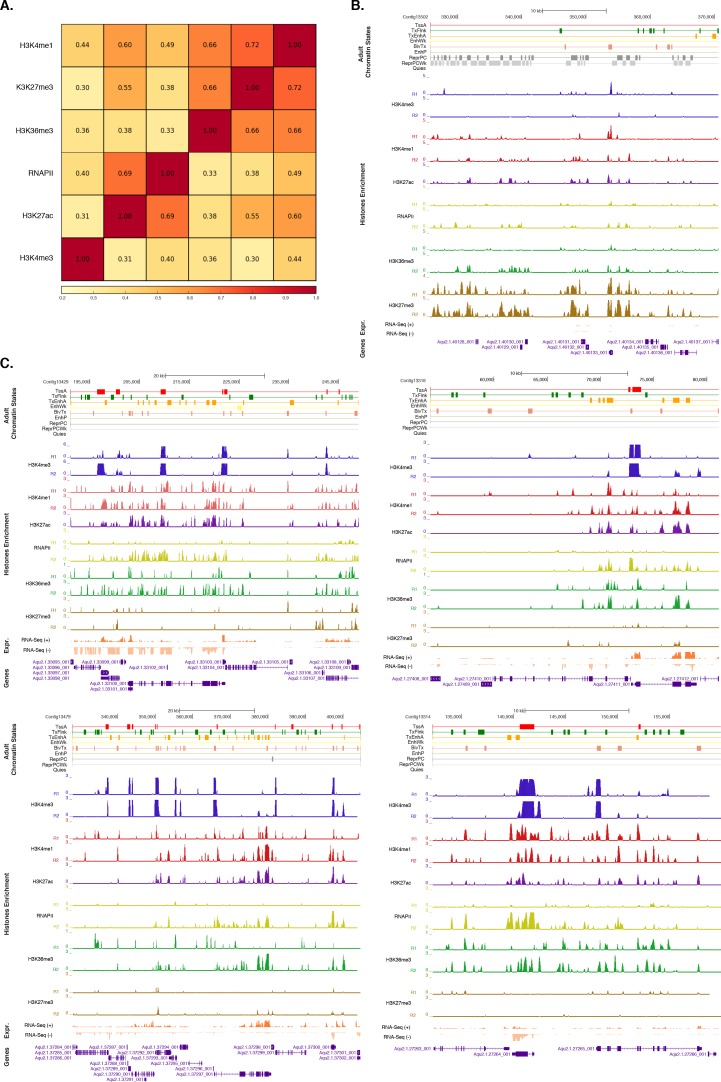
Assessment of reproducibility for biological replicates between histone modifications andRNA Polymerase II.(A) Pearson correlation coefficients between histone modifications and RNA Polymerase II (RNAPII). Adult experiments (combined biological replicates) are shown. Underlying colors indicate the similarity between the different datasets. Note that H3K36me3 was flagged for low signal to noise, potentially explaining the somewhat high correlation with H3K27me3 (see Figure 1—source data 4). However, this does not affect the conclusions of the paper in any way. (B) Adult chromatin state annotations on a predominantly silenced region. For the definition of chromatin states see Figure 1A. Coding genes (purple) are shown, along with input DNA-normalized coverage of each biological replicate (R1 and R2) of different histone modifications and RNA-seq expression. (C) Same as (B) for highly transcribed regions. Apart from RNAPII replicate 1, which did not pass the quality threshold required so it has been excluded from all further analyses (see Figure 1—source data 4), we obtained highly reproducible data sets.